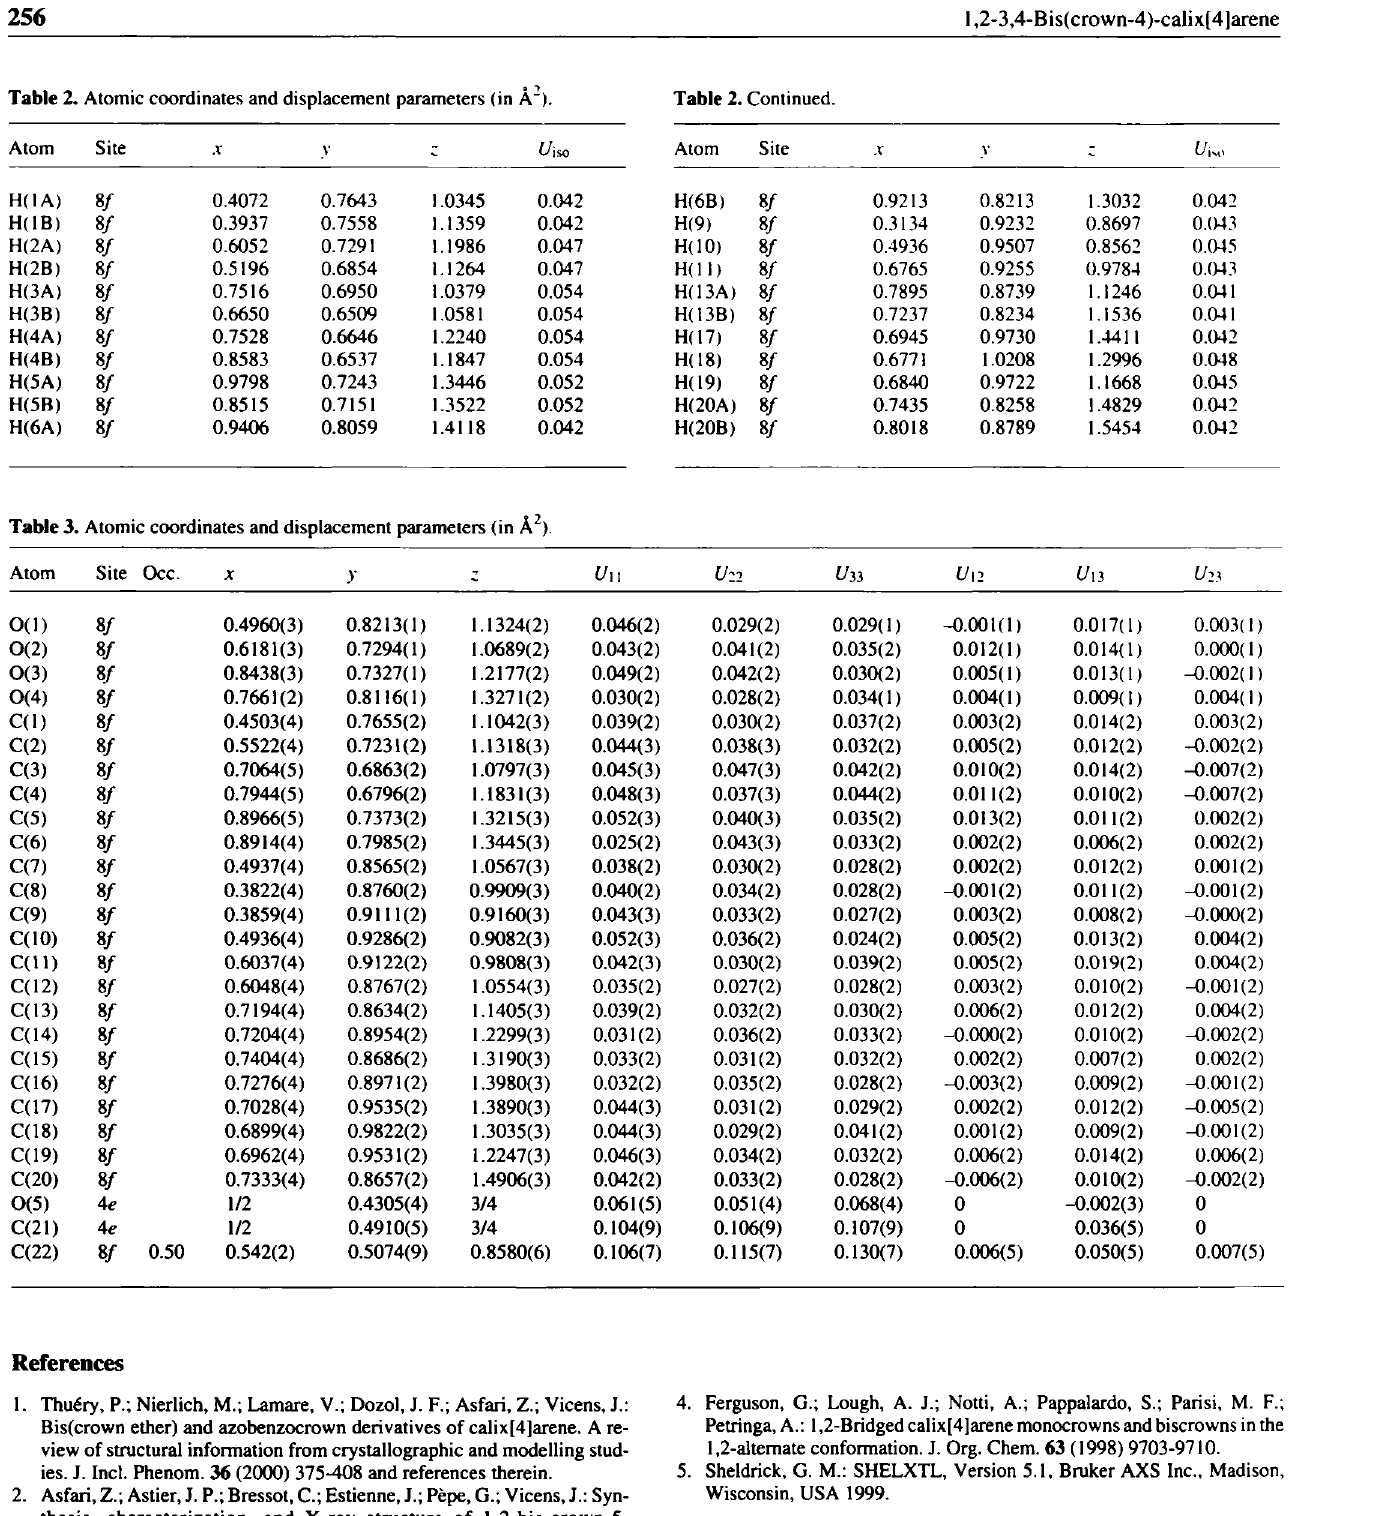
Table 3. Atomic coordinates and displacement parameters (in Ä 2